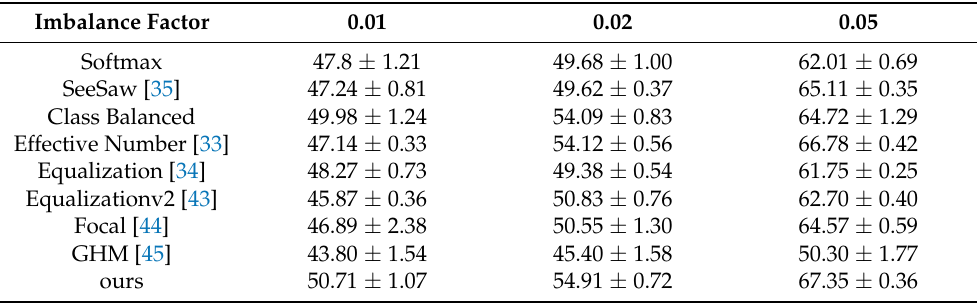
Table 3. Comparison results of the proposed method with other similar advanced methods on the long-tailed SIRI-WHU dataset with imbalance factors of 0.01, 0.02, and 0.05. The values in the table are the top1 OA